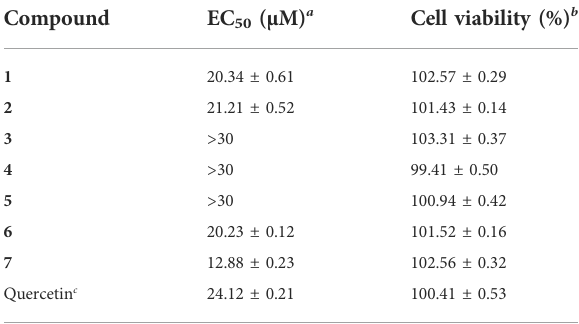
TABLE 4 Anti-NO production activity of compounds 1 ‒ 7.